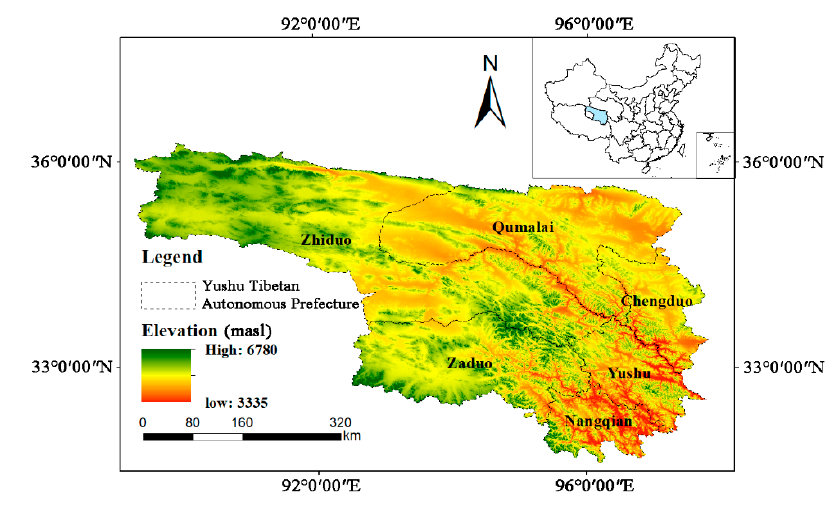
Figure 1. Location of study area.